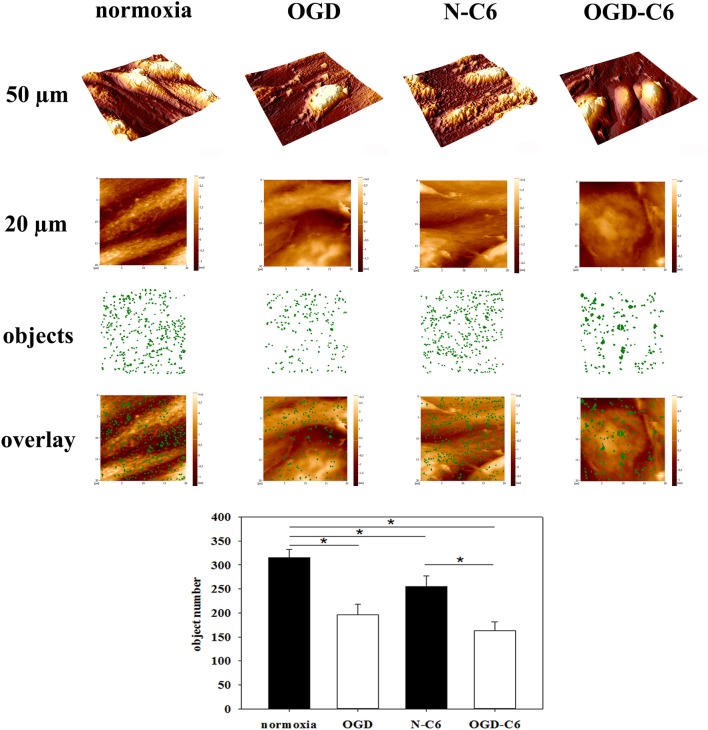
Nanoscale surface topography analysis (nAnostic). CerebEND cells after 4 h oxygen/glucose-deprivation (OGD) and/or incubation with astrocyte conditioned medium were fixed by addition of glutardialdehyde (1% final conc.) and subjected to topography recording through atomic force microscopy (AFM) in buffer fluid—without any drying or labeling procedure. Quantitative analysis of protruding nano-objects is performed by computer vision. Shown are 3D-overviews of 50 μm (upper row), 20 μm raw data as taken for quantitative analysis (2nd row), a mask of identified nano-objects in green (3rd row) and the overlay of the two latter (lower row). Normoxia, cerebEND cells 4 h normoxia; OGD, cerebEND cells 4 h OGD; N-C6, cerebEND cells 4 h normoxia with C6-medium; OGD-C6, cerebEND cells 4 h OGD with C6-OGD medium. Statistical significance was indicated with an *(p < 0.05 two-sided student's t-test with same variances). Data are presented as means ± s.e.m. of n = 20 images of (20 μm)2 area.